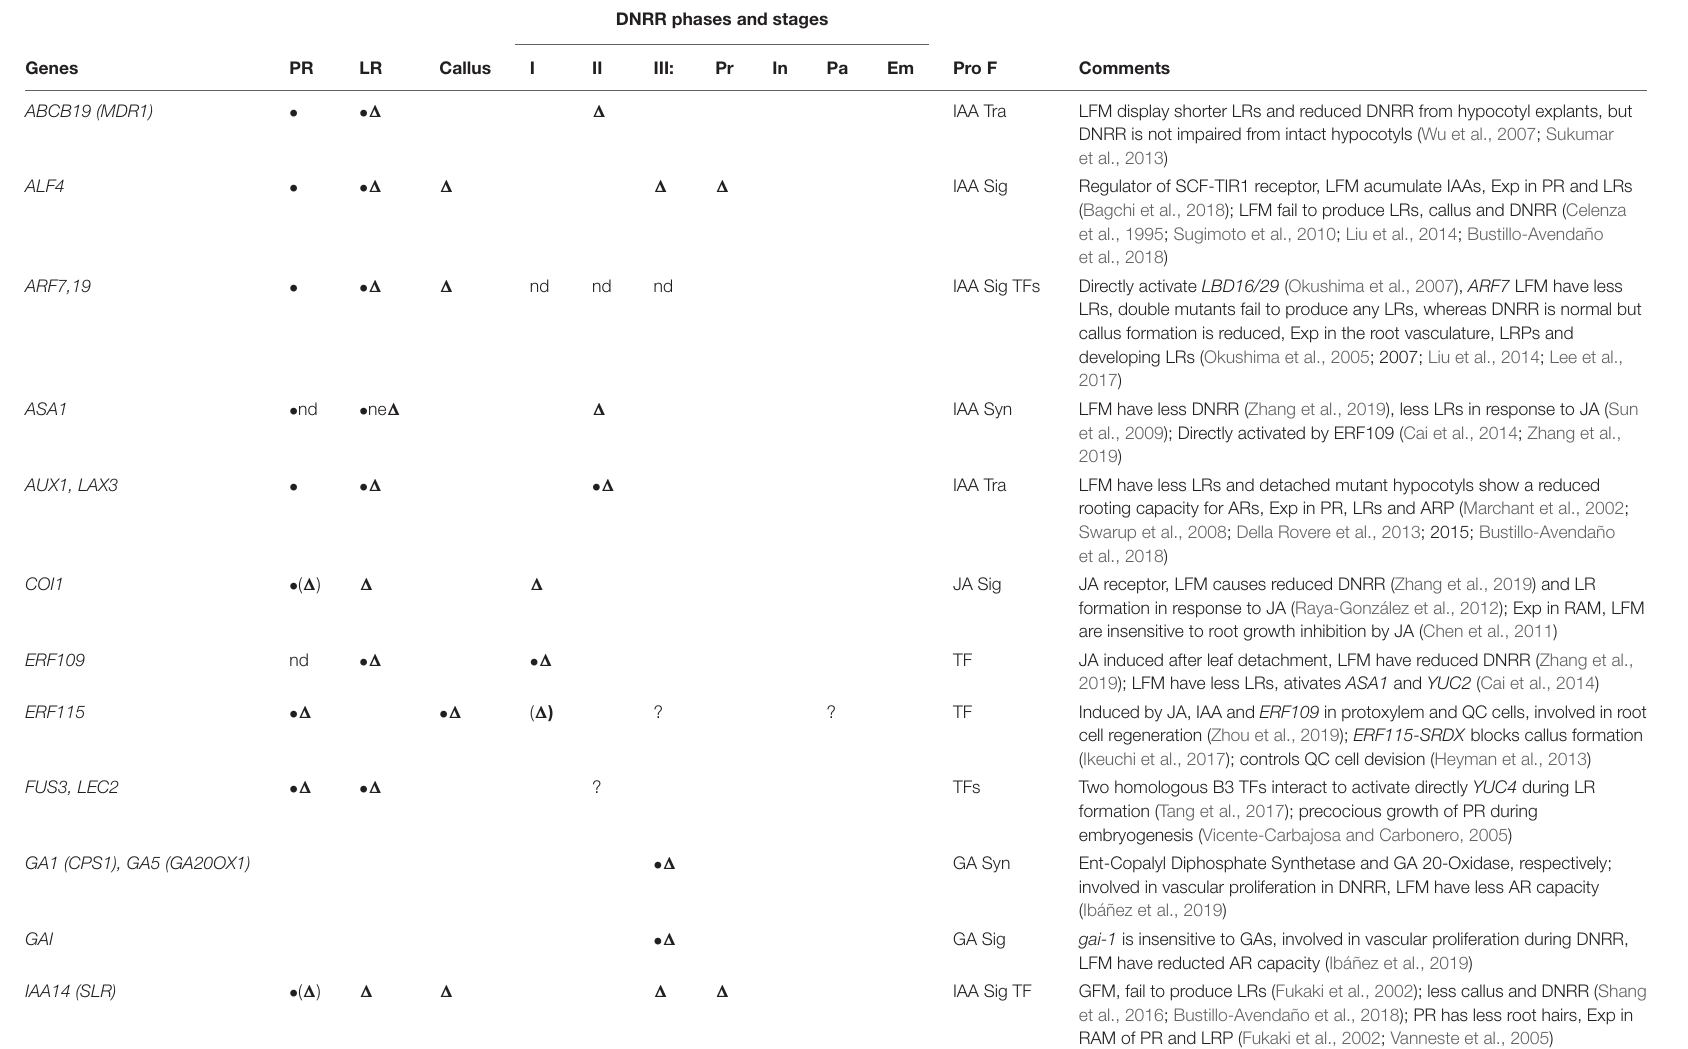
TABLE 1 | Selection of transcription factors and components of phytohormone signaling evidently or putatively involved in DNRR further indicating their role in primary and lateral root development or callus formation. DNRR phases and